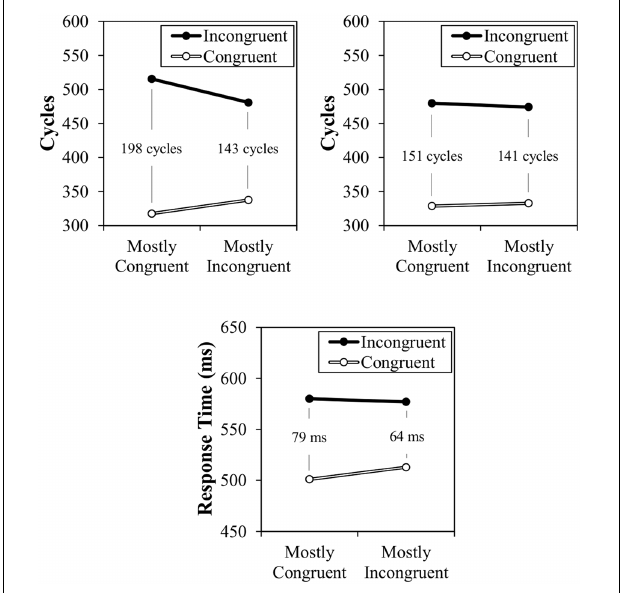
FIGURE 5 | Simulation 1 normal model cycle times (top left), lesioned model cycle times (top right), and participant response times